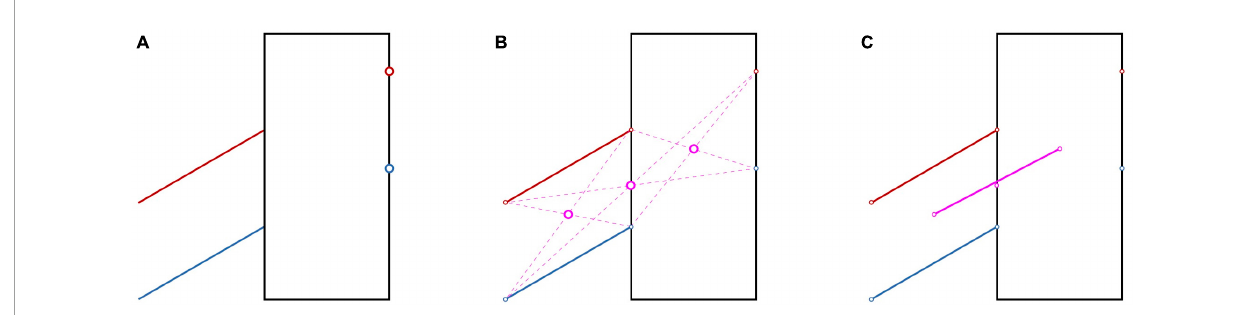
FIGURE6 How the Poggendorff illusion warps visual space. (A) The red and blue disks on the right are perceptually aligned with the lines with the same color on the left. The alignment is illusory, as they are not aligned. (B) The three purple disks are the intersections between the diagonals obtained by connecting each of the three red points on the upper line with the two blue points on the lower line that are farthest away. (C) If the manipulations in (A,B) would have resulted in a homogeneous space, the three purple disks should be aligned. The straight line shows they do not: the central disk is slightly below the straight line. This is obviously a consequence of the error we introduced in (A) . We showed experimentally that if one constructs the three positions indicated by the purple disks perceptually, they are also not aligned (Smeets et al., 2009).